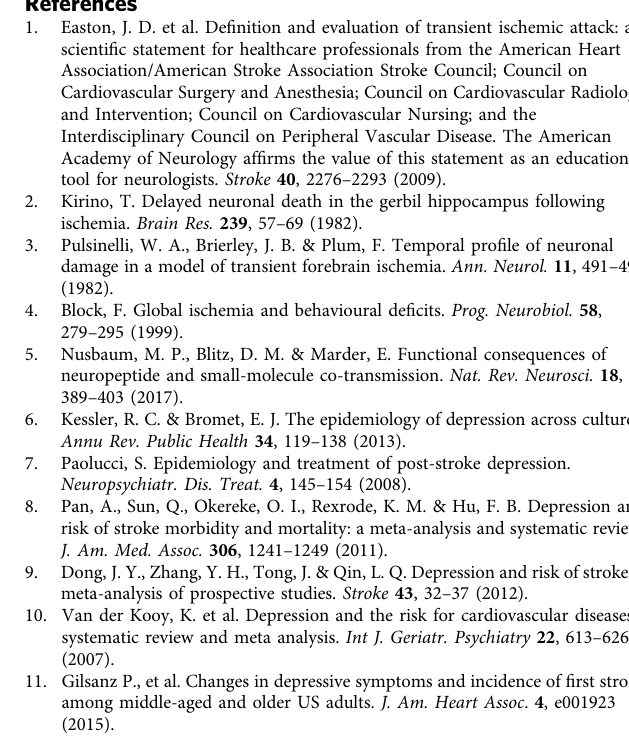
Fig. 7 Th:LC-CA1 circuit activation relieves CFS-induced TGI susceptibility. a Schematic representation of the construct of the AAV-DIO-hM3Dq-mCherry and AAV-TH-Cre virus. b The mixture viruses including AAV-DIO-hM3Dq-mCherry and AAV-TH-Cre were bilaterally injected into LC area. c Experimental timeline. d The immobility time by FST. Control ( n = 15), CFS ( n = 18). Unpaired two-tailed Student ’ s t test, P = 0.0086**. e Spatial learning curves in the MWM test (RM two-way ANOVA, interaction: P = 0.0029**, time: P < 0.0001***, treatment: P < 0.0001***). f Escape latency on day 6. Control/Saline ( n = 9), Control/CNO ( n = 6), CFS/Saline ( n = 7), CFS/CNO ( n = 11). Two-way ANOVA, interaction: P < 0.0001***, Control vs. CFS: P = 0.0007***, Saline vs. CNO: P = 0.0002***; post hoc Dunnett's test, CFS/Saline vs. CFS/CNO, P < 0.0001***, Control/Saline vs. CFS/Saline, P <